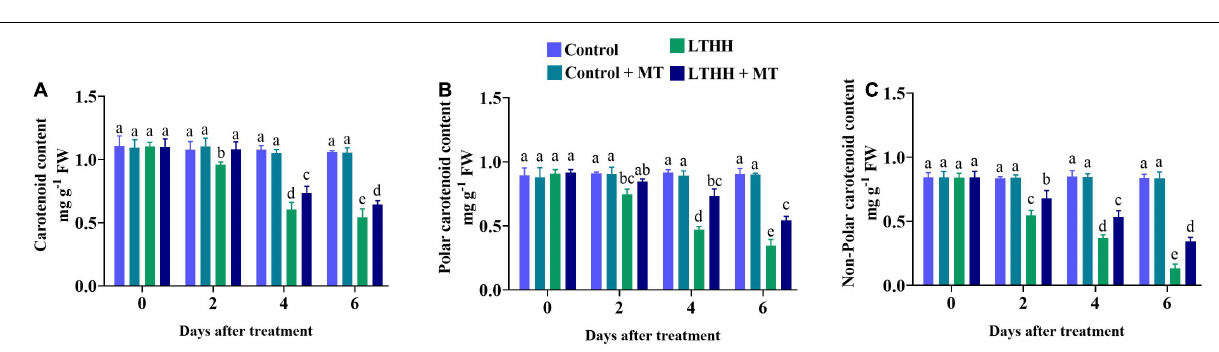
FIGURE 6 | Effect of exogenous melatonin on carotenoid (A) , polar carotenoid (B) , and non-polar carotenoid (C) content of cucumber seedling under low-temperature and high-humidity stress. Control (25/18 ◦ C); Control ± MT (200 µ M melatonin, 25/18 ◦ C); LTHH (15/10 ◦ C, 95%); LTHH + MT (200 µ M melatonin, 15/10 ◦ C, 95%). Same letters on the bars represent no significant differences, while different letters represent significant differences among treatments ( P > 0.05 was non-significant). Data are means ± SD of three replicates ( n =